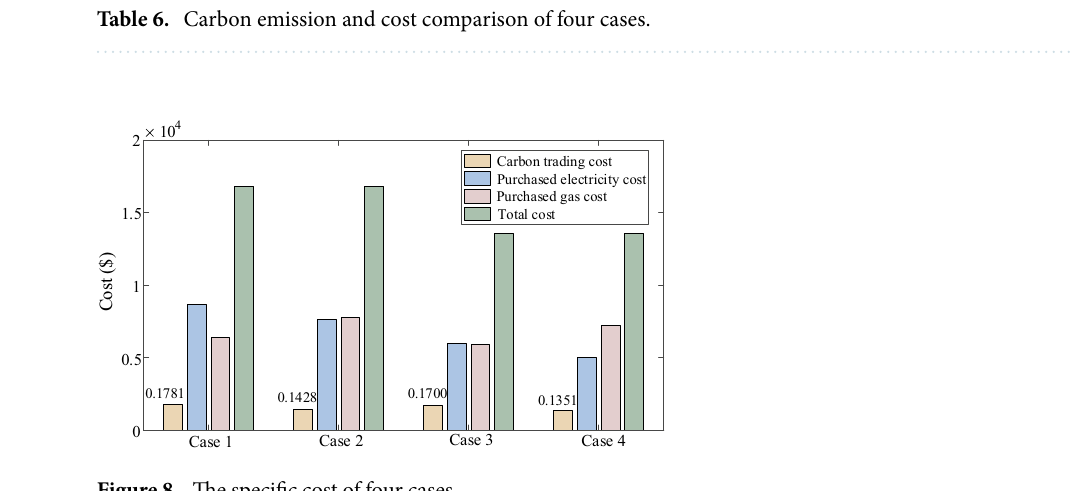
Figure 8. The specific cost of four cases.